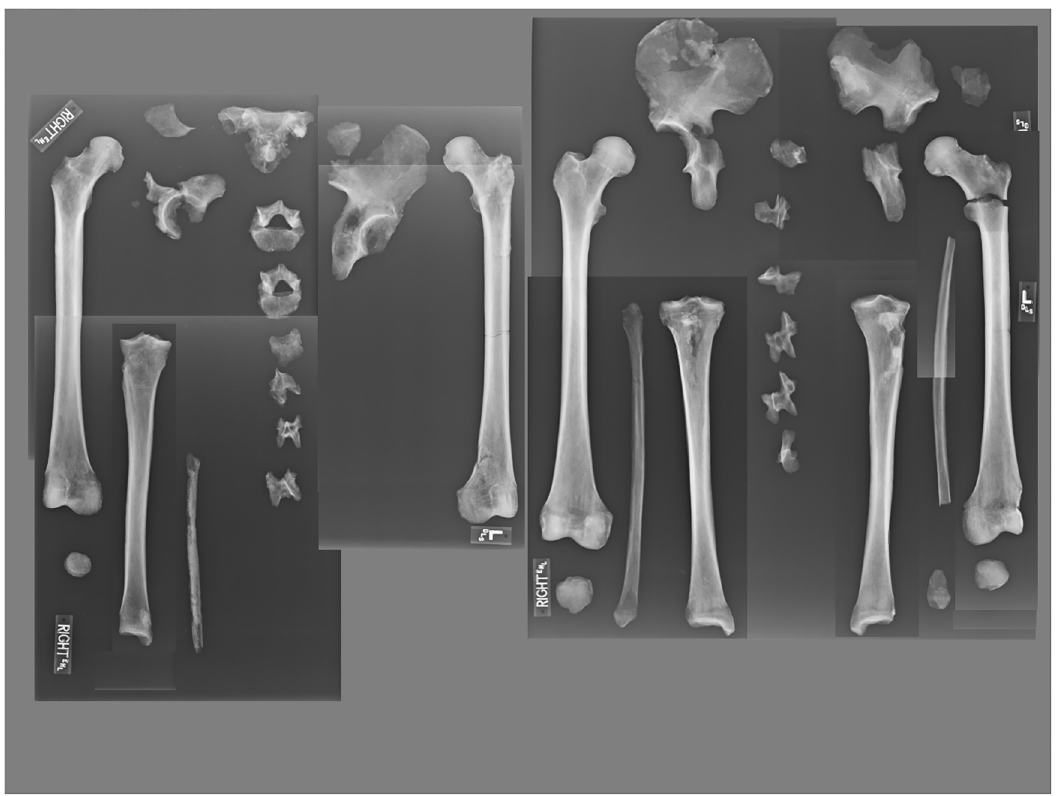
Fig 13. Comparison of YNH4 B (left) and B2 (right) lower limb radiographs. Note relatively higher translucence and lower bone density in B relative to B3. See text for